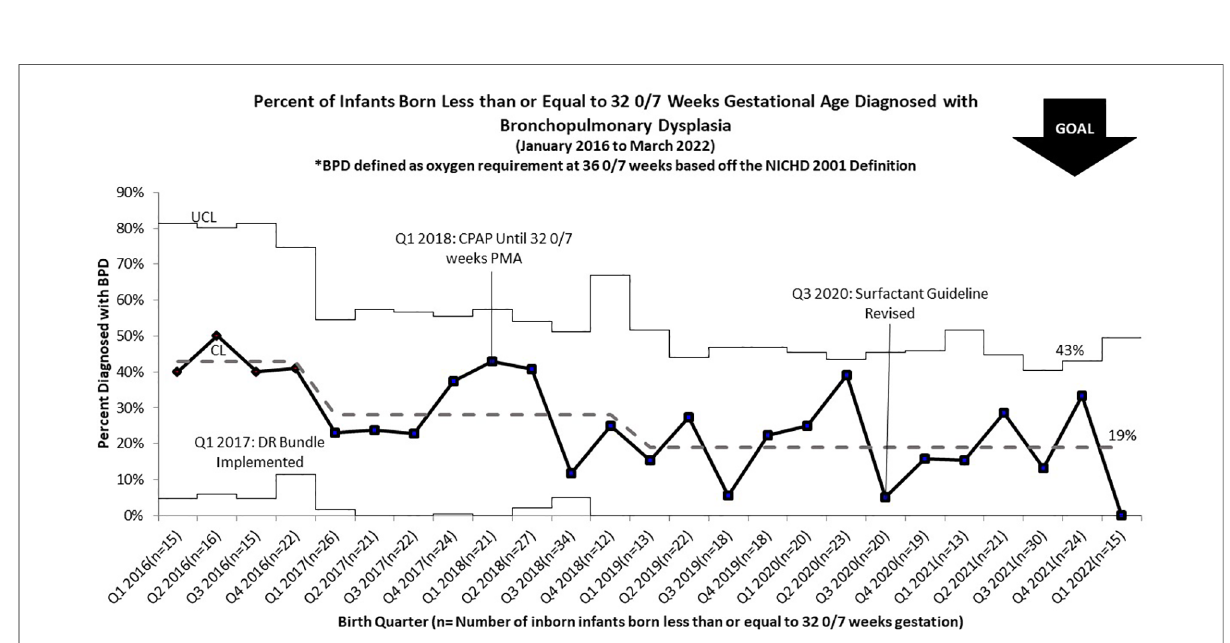
FIGURE 5 p chart for percent of infants born less than or equal to 32 0/7 weeks gestation diagnosed with BPD by NICHD criteria.